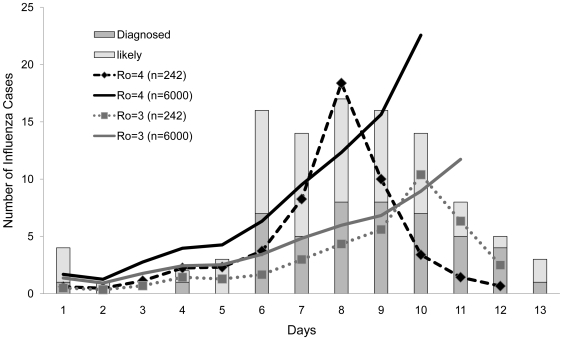
Determination of the model Ro from the SOPS epidemic curve.The number of observed and likely daily influenza cases (based on a pilgrims reported symptom onset date) at the SOPS clinic compared to the number of daily cases when decisions are made on the combination of the SOPS Outbreak case definition and a POCT result and using different Ro values. The likely epidemic curve represents the observed cases and the additional cases that would have resulted if all individuals presenting were tested. The Ro values are modeled on a closed population of 242 (the number of pilgrims presenting to the SOPS clinic) and 6000 (the minimum number of pilgrims accommodated at the SOPS).